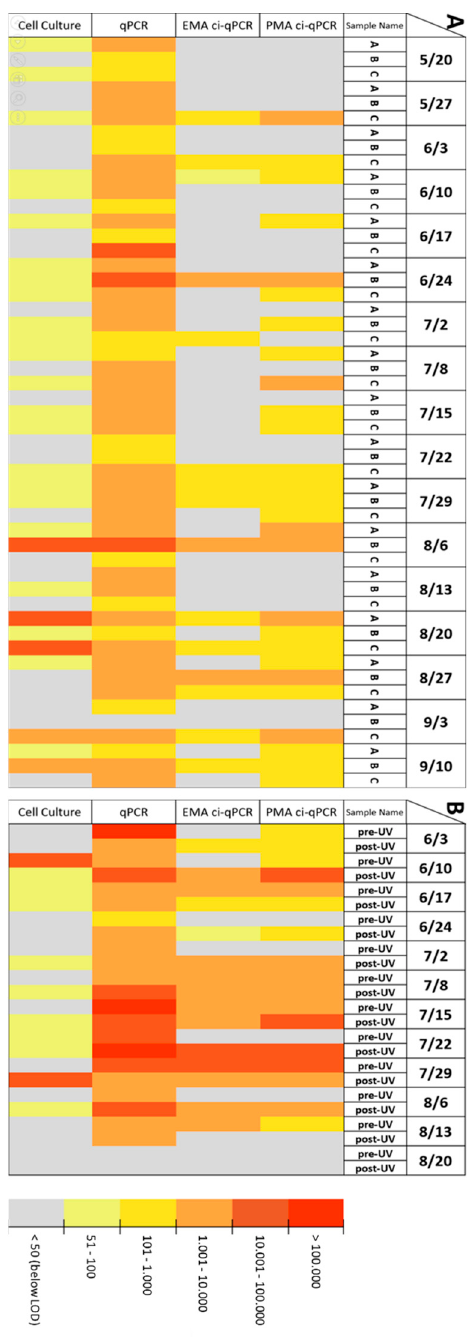
Figure 4. ( A ) Concentrations of HAdV obtained by qPCR, cell culture, EMA ci-qPCR, and PMA ci-qPCR between May and September 2015 from the sampled bathing site on the River Ruhr, Essen, Germany. Molecular detection with no signal is indicated as half the limit of detection. ( B ) Concentrations of HAdV obtained by qPCR, cell culture, EMA-ci-qPCR and PMA-ci-qPCR between June and August 2015 before (pre-) and after (post-) UV treatment at the wastewater treatment facility Essen-Süd in Essen, Germany. Molecular detection with no signal is indicated with results lower than half the detection limit (LOD) of 25 copies per liter for molecular detection and 2 infectious virions per liter for cell culture. Values as gene copies per liter per sample.